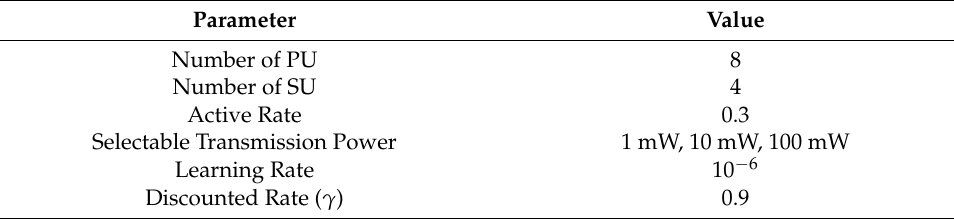
Table 2. Parameters of the second simulation (Multiple SUs).